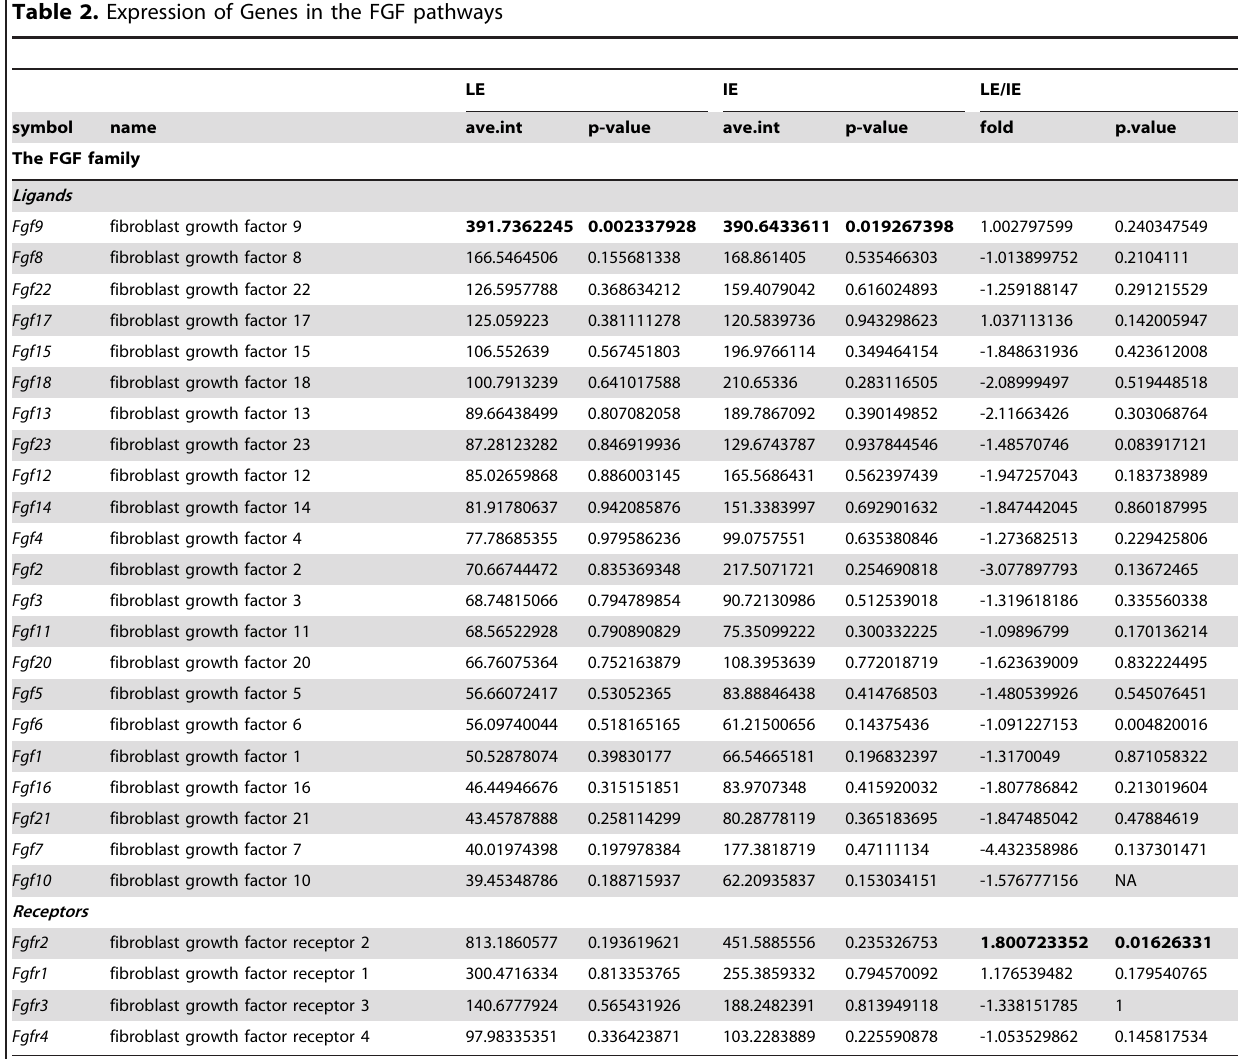
Table 2. Expression of Genes in the FGF pathways